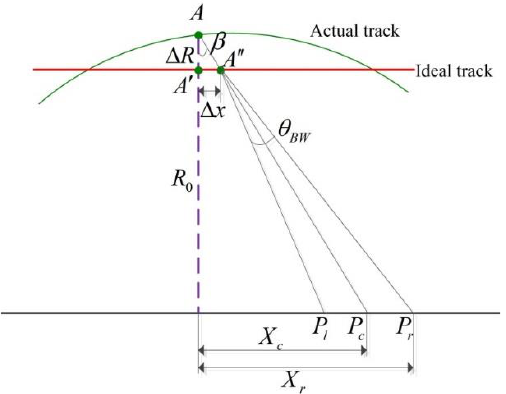
Figure 3. Azimuth motion displacement variation model.